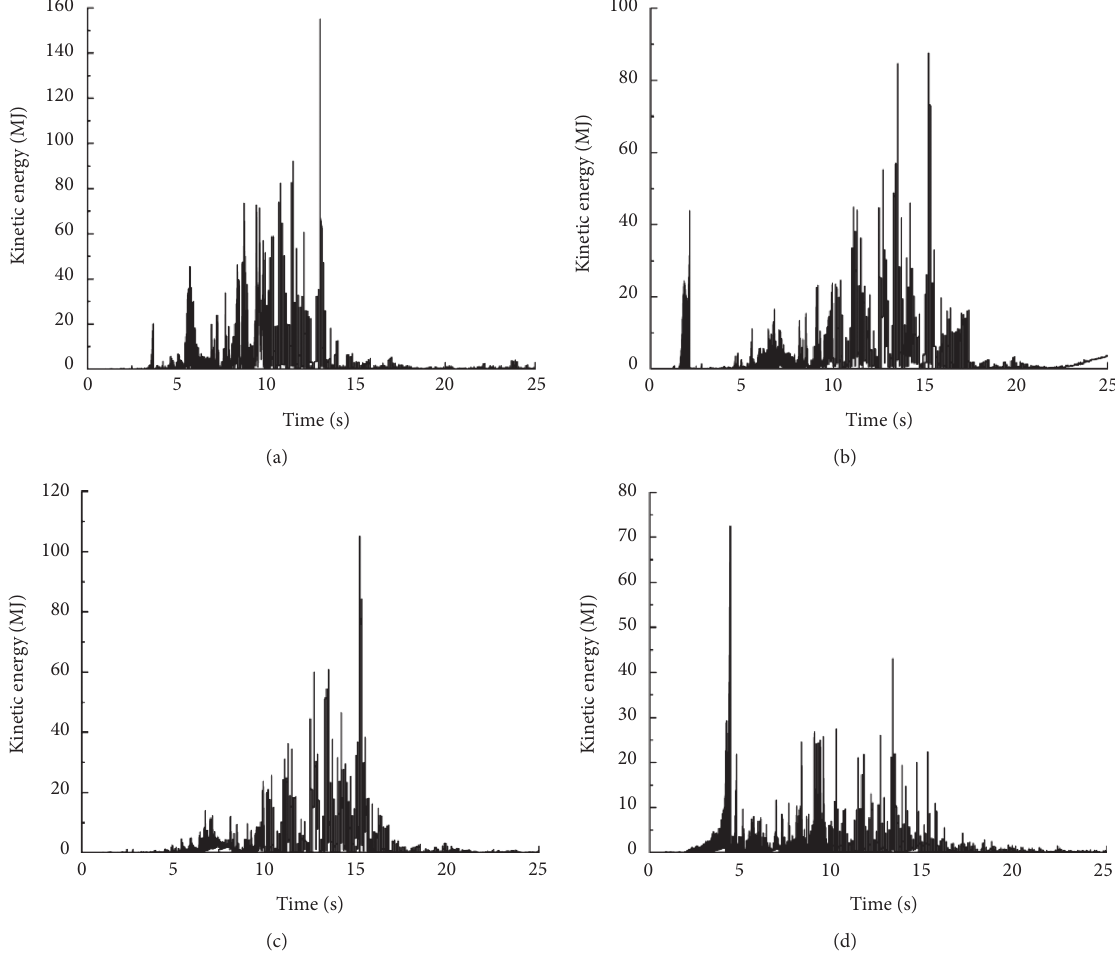
Figure 15: Variation of kinetic energy response of each model. (a) Model 1. (b) Model 2. (c) Model 3. (d) Model 4.